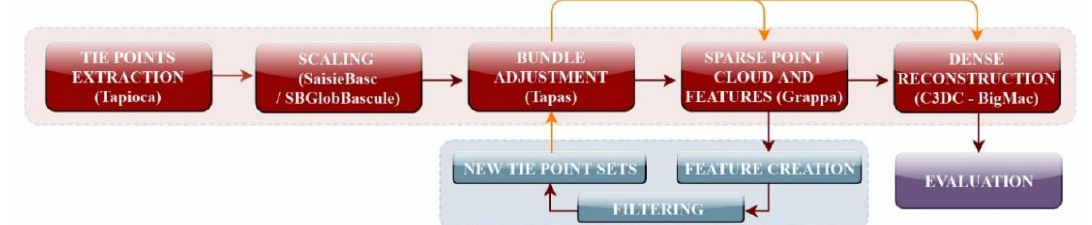
Figure 3: The pipeline flowchart, developed with the MicMac suite. The standard workflow (red blocks) is extended with the filtering procedure developed in Python (blue blocks) for the removal of bad estimated 3D tie points in order to improve the orientation results and the dense 3D